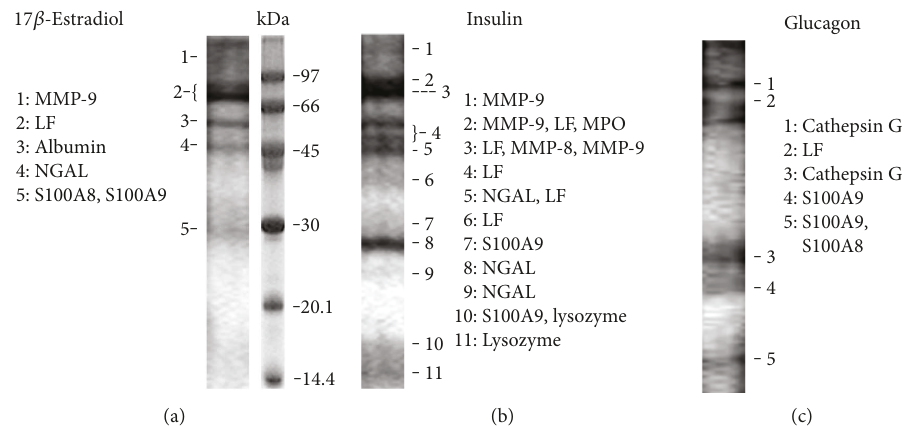
Figure 3: SDS-PAGE separation of proteins secreted by neutrophils upon adhesion to fi bronectin in the presence of hormones. Human neutrophils were attached to fi bronectin-coated substrata for 20min in the presence of 0.1 μ M E2 (a), 0.1 μ M insulin (b), or 0.1 μ M glucagon (c). Samples of extracellular medium were collected, and proteins were extracted and subjected to 15% SDS-PAGE. Pictures represent typical protein pro fi les observed in the three independent experiments for each hormone. Table 2: List of proteins secreted by neutrophils in adherence to fi bronectin in the presence of hormones. Protein